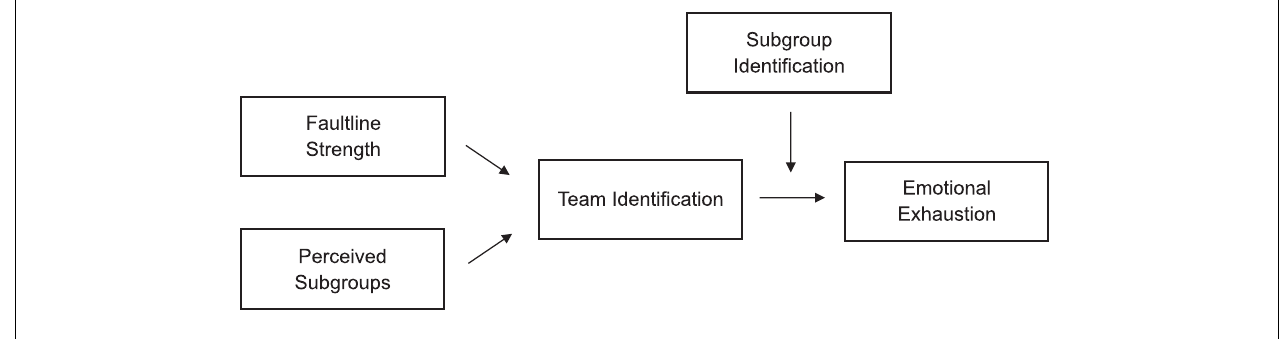
FIGURE 1 | Graphical summary of our